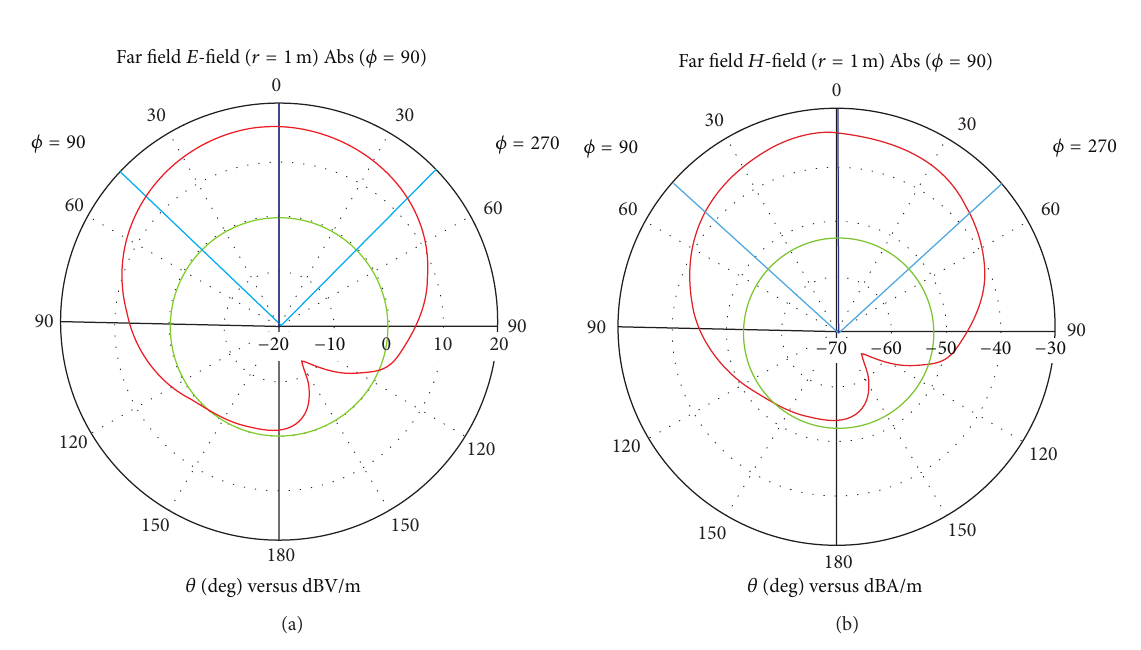
Figure 5: First stage of proposed antenna. (a) E -field and (b) H